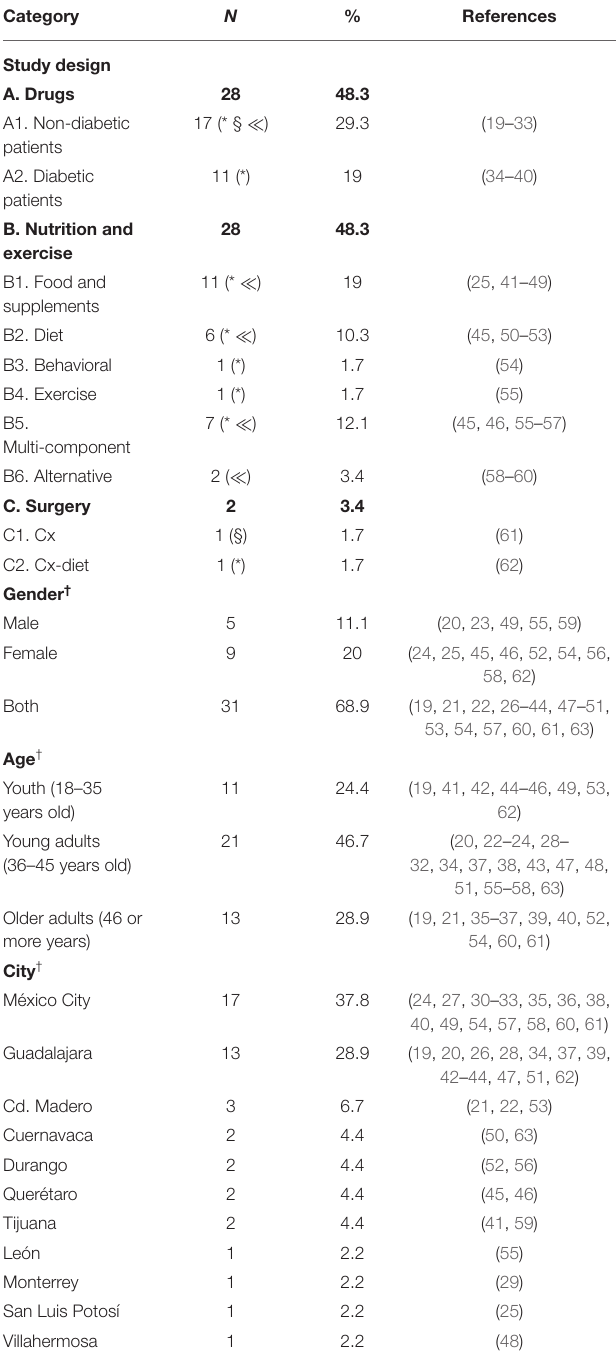
TABLE 1 | Characteristics of the analyzed interventions ( n =